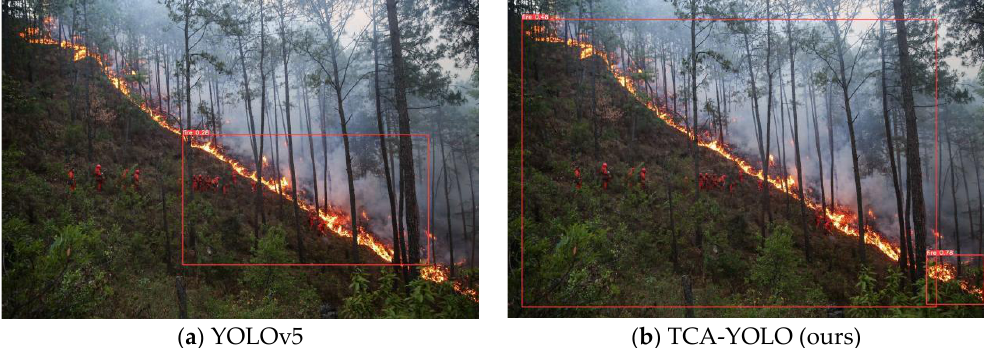
Figure 11. Comparison of global information extraction ability for forest fires. ( a ) YOLOv5 locates only a local area of the fire target. ( b ) Our model locates the global area of the fire target. As shown in Figure 12, YOLOv5 has multiple missed targets when facing forest fire targets at different scales, while TCA-YOLO has no missed targets.